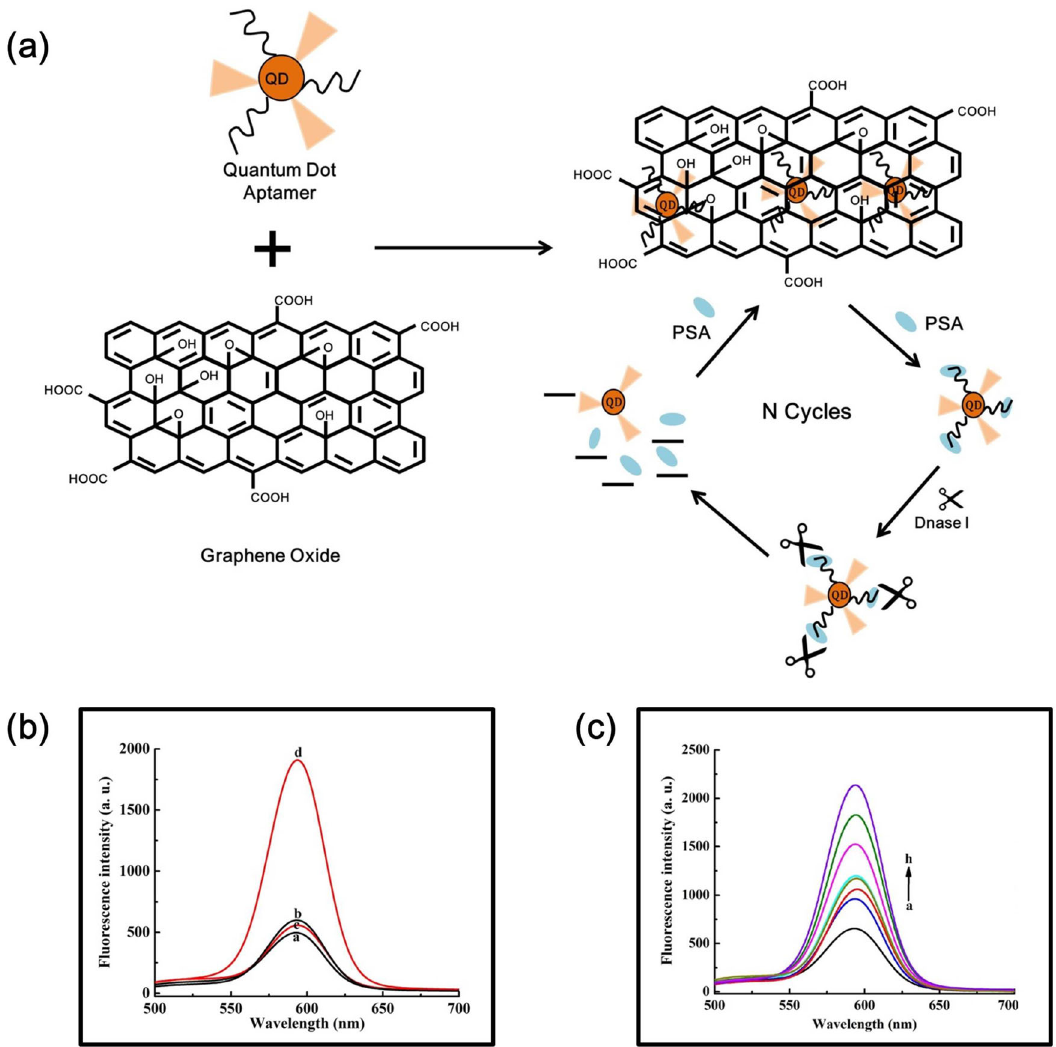
Fig. 7 Detection of PSA. a DNase I and QD – aptamer/GO-based hybrids for ampli fi ed detection of PSA. b PSA increased the fl uorescence of QD – aptamer/GO signi fi cantly in the presence of DNase I (curve c → d) in comparison with fl uorescence recovery in the absence of DNase I (curve a → b). c The fl uorescence intensity also increased with increasing PSA concentration suggesting high ef fi ciency of the detection system. Adapted with permission from ref. 64 , Copyright 2017,